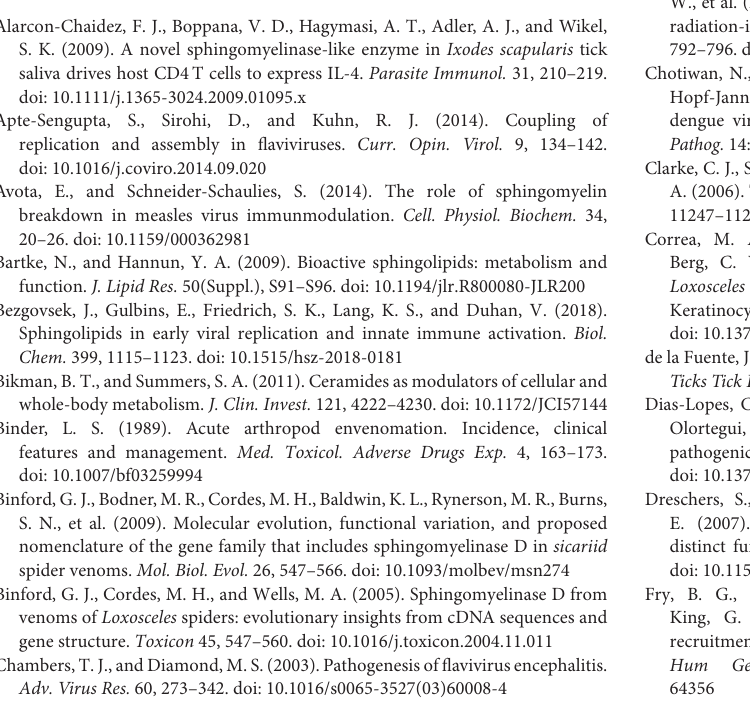
Supplementary Figure 1 | Amplification of I. scapularis sphingomyelinase-like gene fragment ( Is SMase) from ticks and tick cells. PCR amplification of Is SMase gene fragment from I. scapularis unfed or post-fed nymphal ticks or uninfected ISE6 tick cell line cDNA is shown. Similar size fragments were amplified from all three tested groups, and band of approximately 194 bp was detected on 1% agarose gel. Marker indicates size of the product amplified and NTC denotes no template control. M represents DNA ladder. Arrows indicate the 200 bp bands on ladder lane. Supplementary Figure 2 | Exosomes derived from tick cells had low or undetectable levels of Is SMase. QRT-PCR analysis showing detectable LGTV loads (A) , HSP70 transcript levels (B) and low or undetectable levels of Is SMase transcripts (C) in tick cell-derived exosomes that are uninfected (UI) or LGTV-infected (I) at day 1 and day 3 post infection (p.i.). Each circle, triangle, inverted triangle, or square represent sample generated from one culture well and analyzed in multiple replicate. Open circles indicate uninfected (UI) and closed circles denotes LGTV-infected group. LGTV loads, hsp70 or Is SMase mRNA